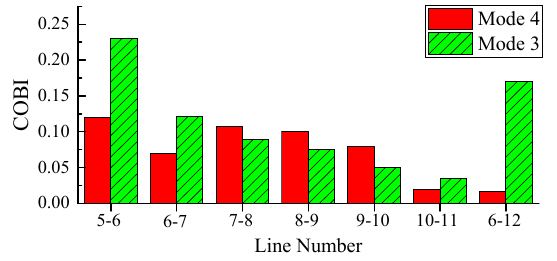
Figure 9. COBI of line active power as the input feedback signal of DFIG POD.